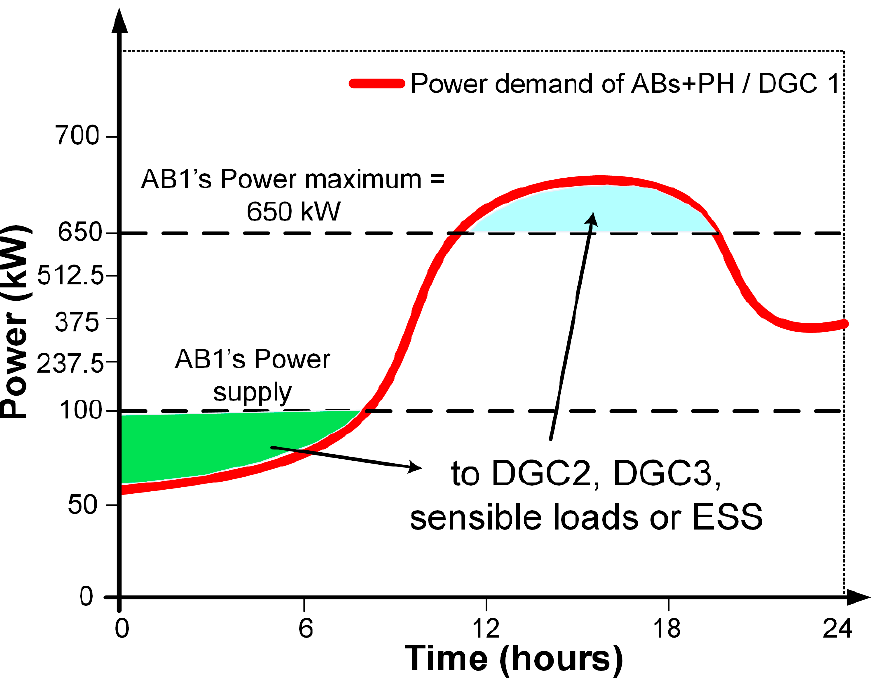
Figure 6. General analysis of the energy exchange process.